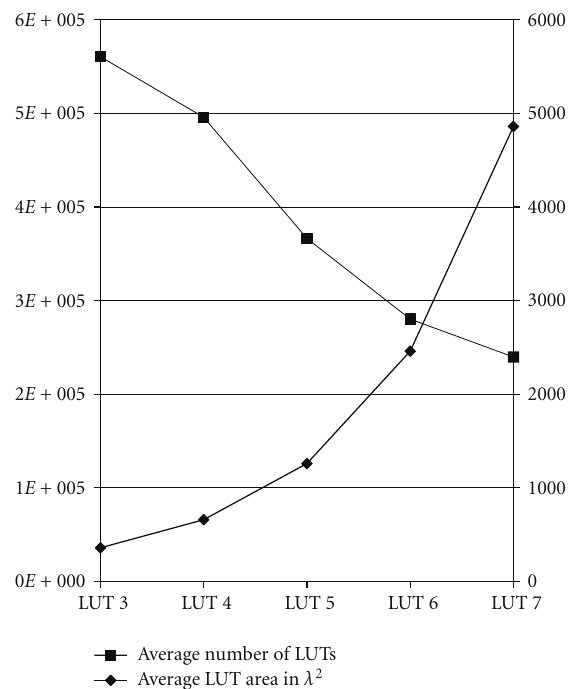
Figure 8: LUTs number and LUT area versus LUT size (for cluster arity = 4).